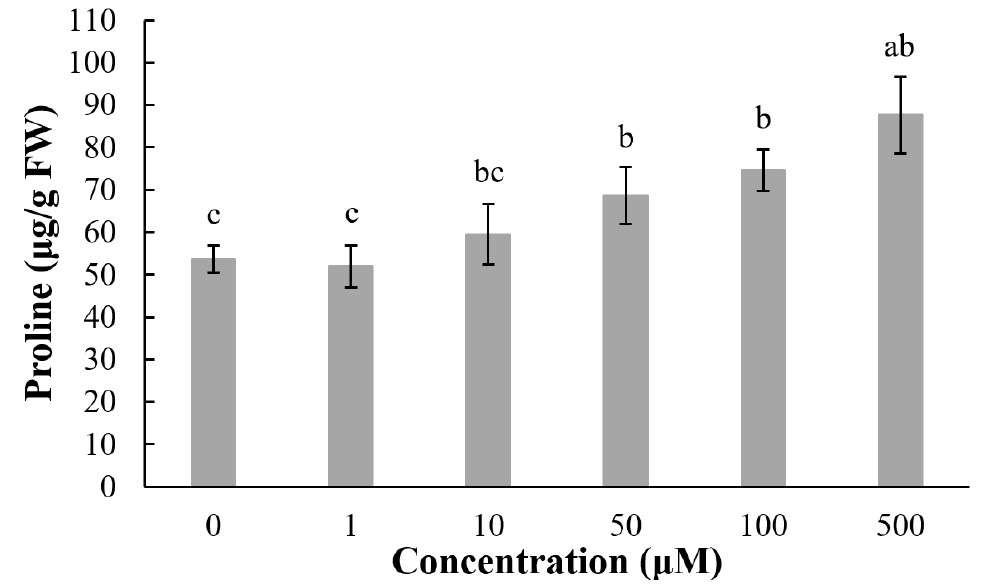
Figure 9. Proline content in roots of lettuce seedlings after treatments with acacetin. The results presented are mean of three replicates ± SE, different letters denote significant differences at p < 0.05 according to one-way ANOVA with an LSD test.